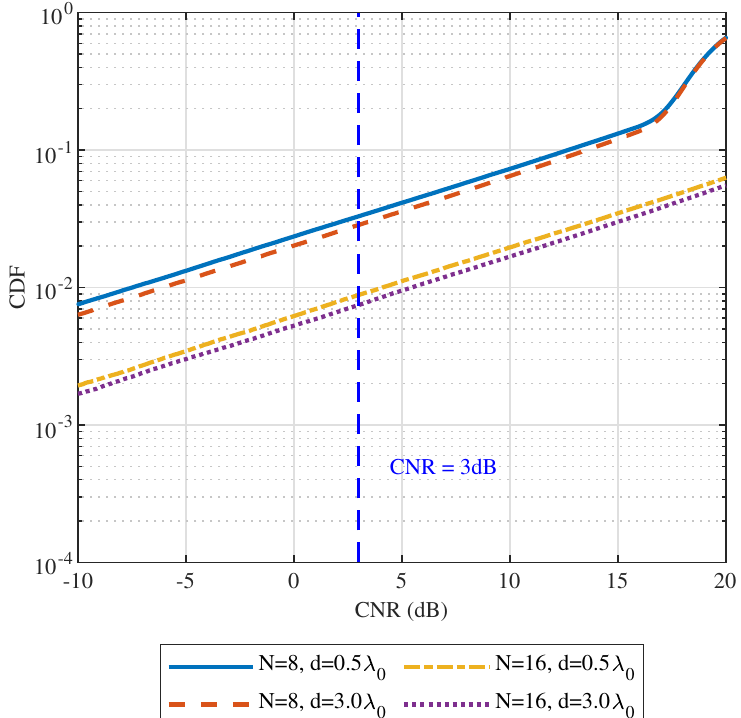
Figure 3. Cumulative distribution function (CDF) of the carrier-to-noise ratio (CNR) for different regular arrays. It is shown that there is only a small difference between dense and sparse arrays, for the cases where N = 8 and N = 16. K = 2 for both